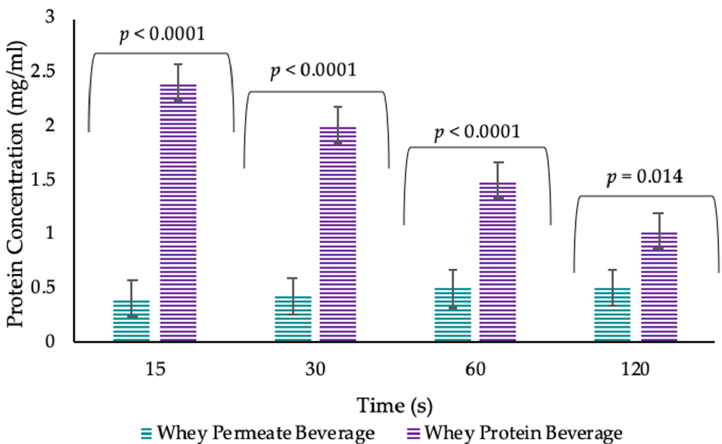
Figure 5. Protein concentration in saliva samples post beverage consumption by timepoints. Values are expressed as LSM estimates ± standard error from SAS output. Significant differences (p < 0.05)